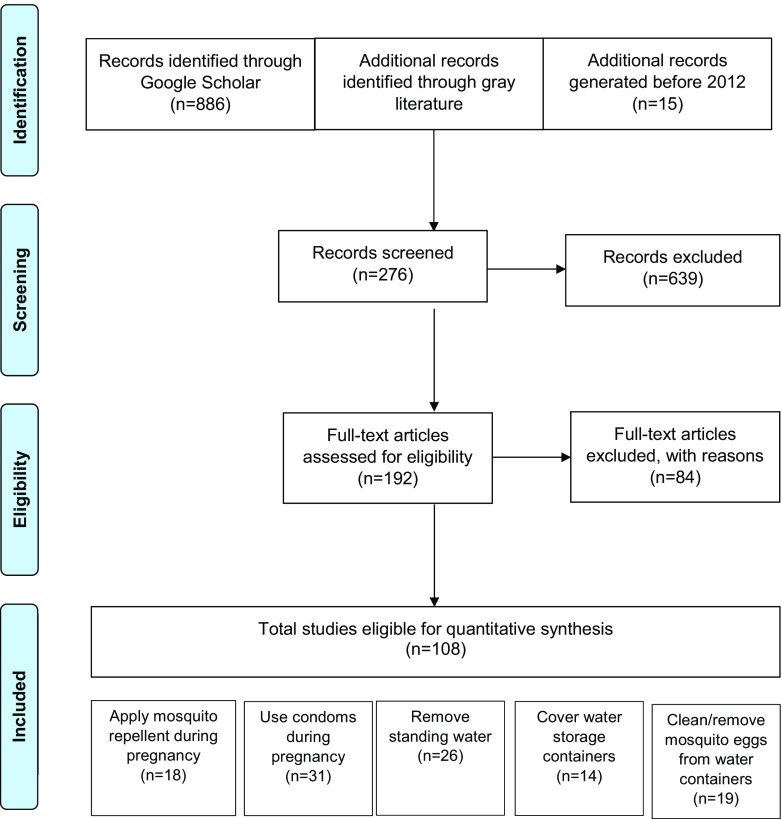
PRISMA Diagram of Process for Considering Eligibility in the Evidence Review